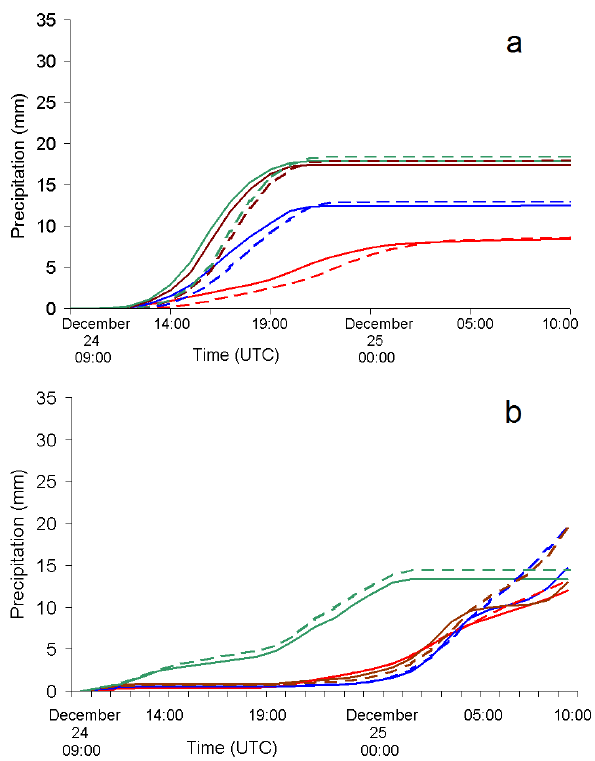
Figure 5. Modeled cumulative precipitation using KF2 (solid lines) and KF1 (dashed lines) and the di ff erence in domains in (a) MM5 and (b) WRF. Domain 1: red, domain 2: blue, domain 3: brown, domain 4: green.